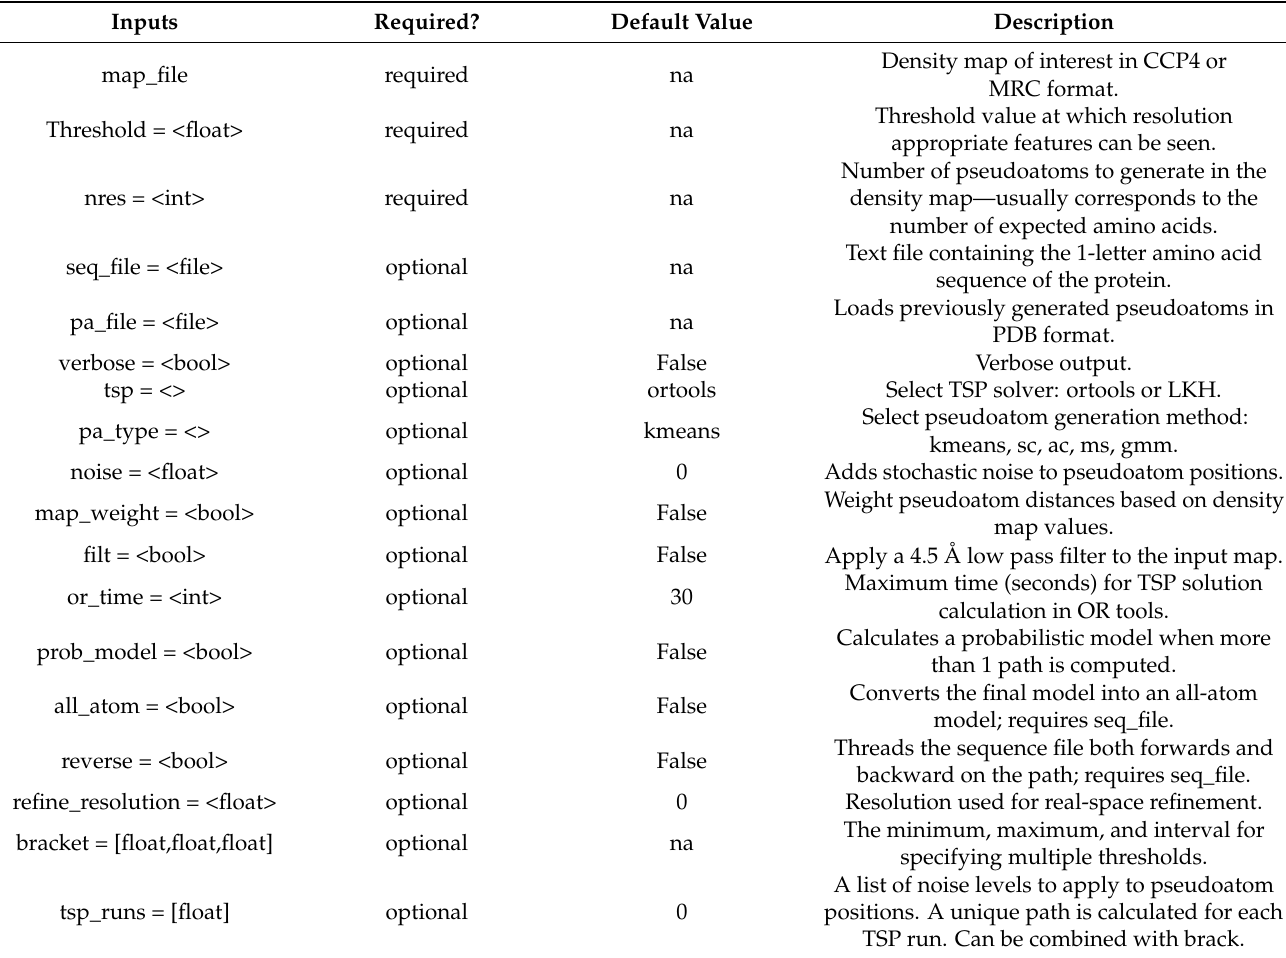
Table 1. Table of Pathwalking options. A list of all command-line inputs, along with a description, value type, and default setting is provided. Pathwalking is invoked using